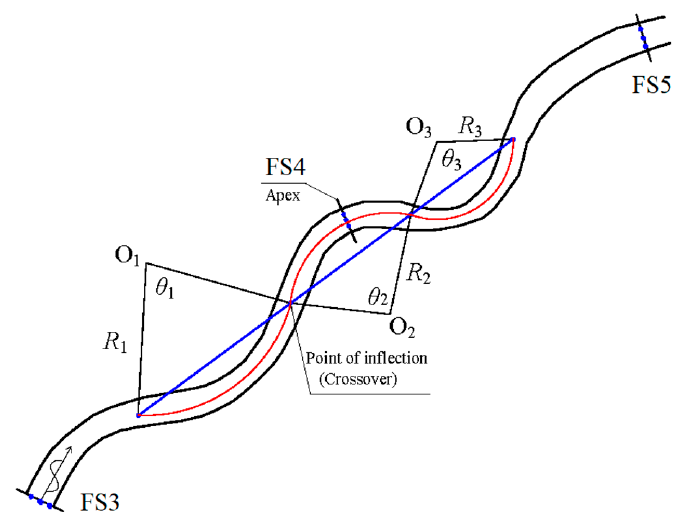
Figure 2. Geometrical description of the meander, with flow and sediment stations FS3, FS4 and FS5. Each bend is described with a center position O , a radius R and an angle θ . The red line denotes the central line throughout the reach.